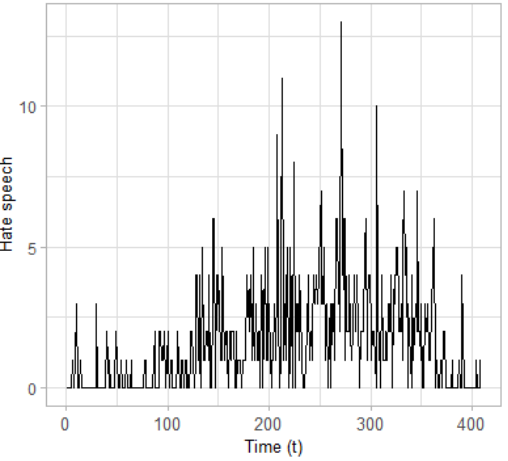
Figure 5. Time series of posts classified as containing hate